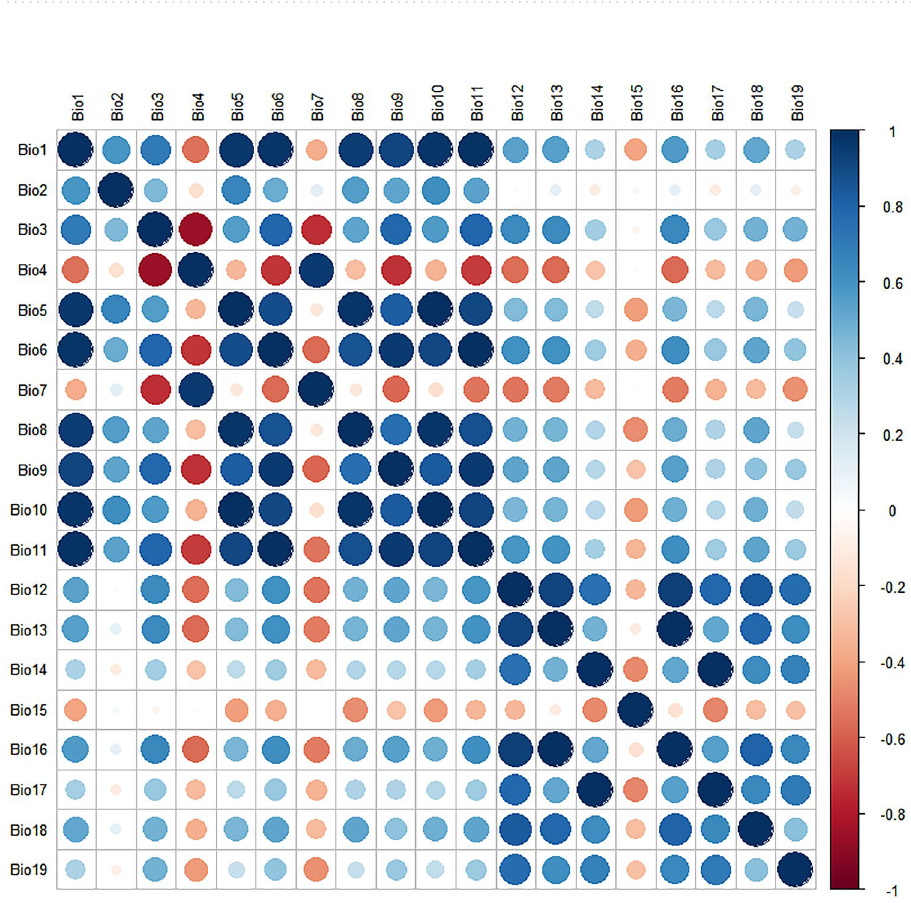
Table 5. List of enviromental variables.